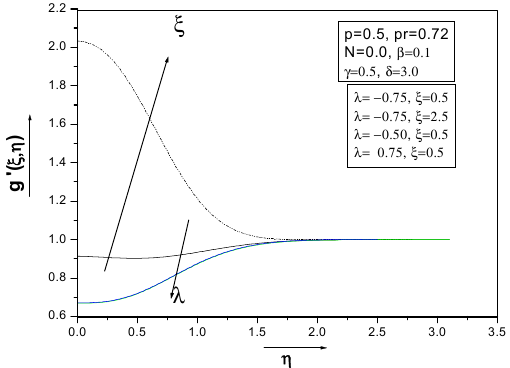
Figure 8. Effect of the temperature exponent parameter on magnetic field profile.